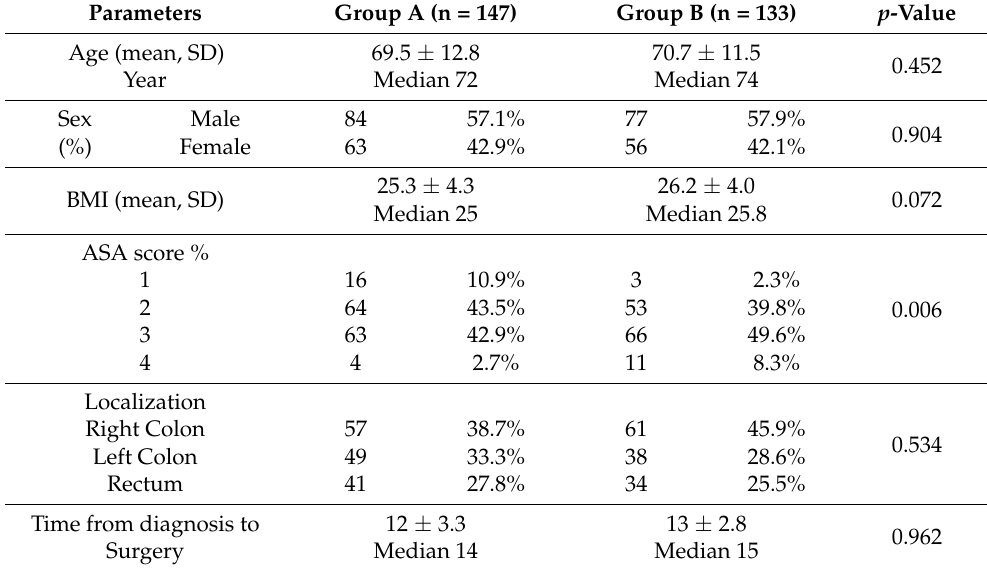
Table 1. Preoperative